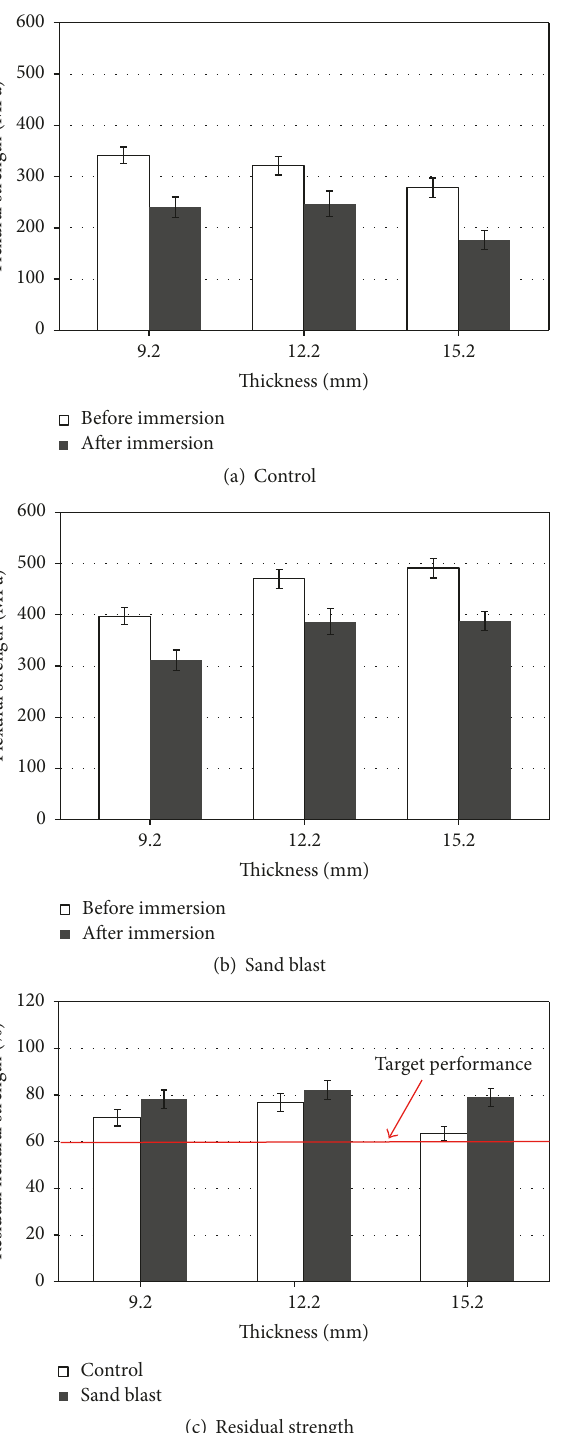
Figure 15: Flexural test results of MgSO 4 solution immersions.